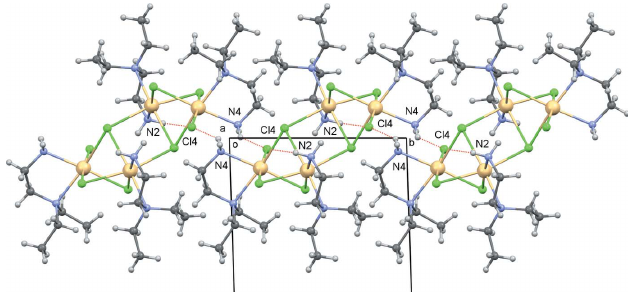
Figure 2 A segment of the crystal packing showing intermolecular N—H (cid:3)(cid:3)(cid:3) Cl contacts as red dotted